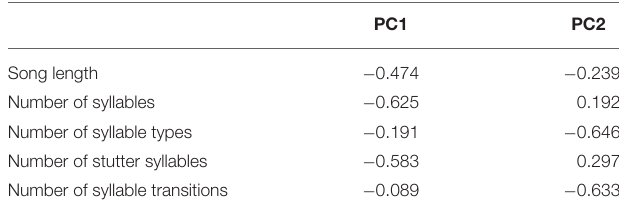
TABLE 2 | The loadings of the five song measures on PC1 and PC2 from the PCA analysis.